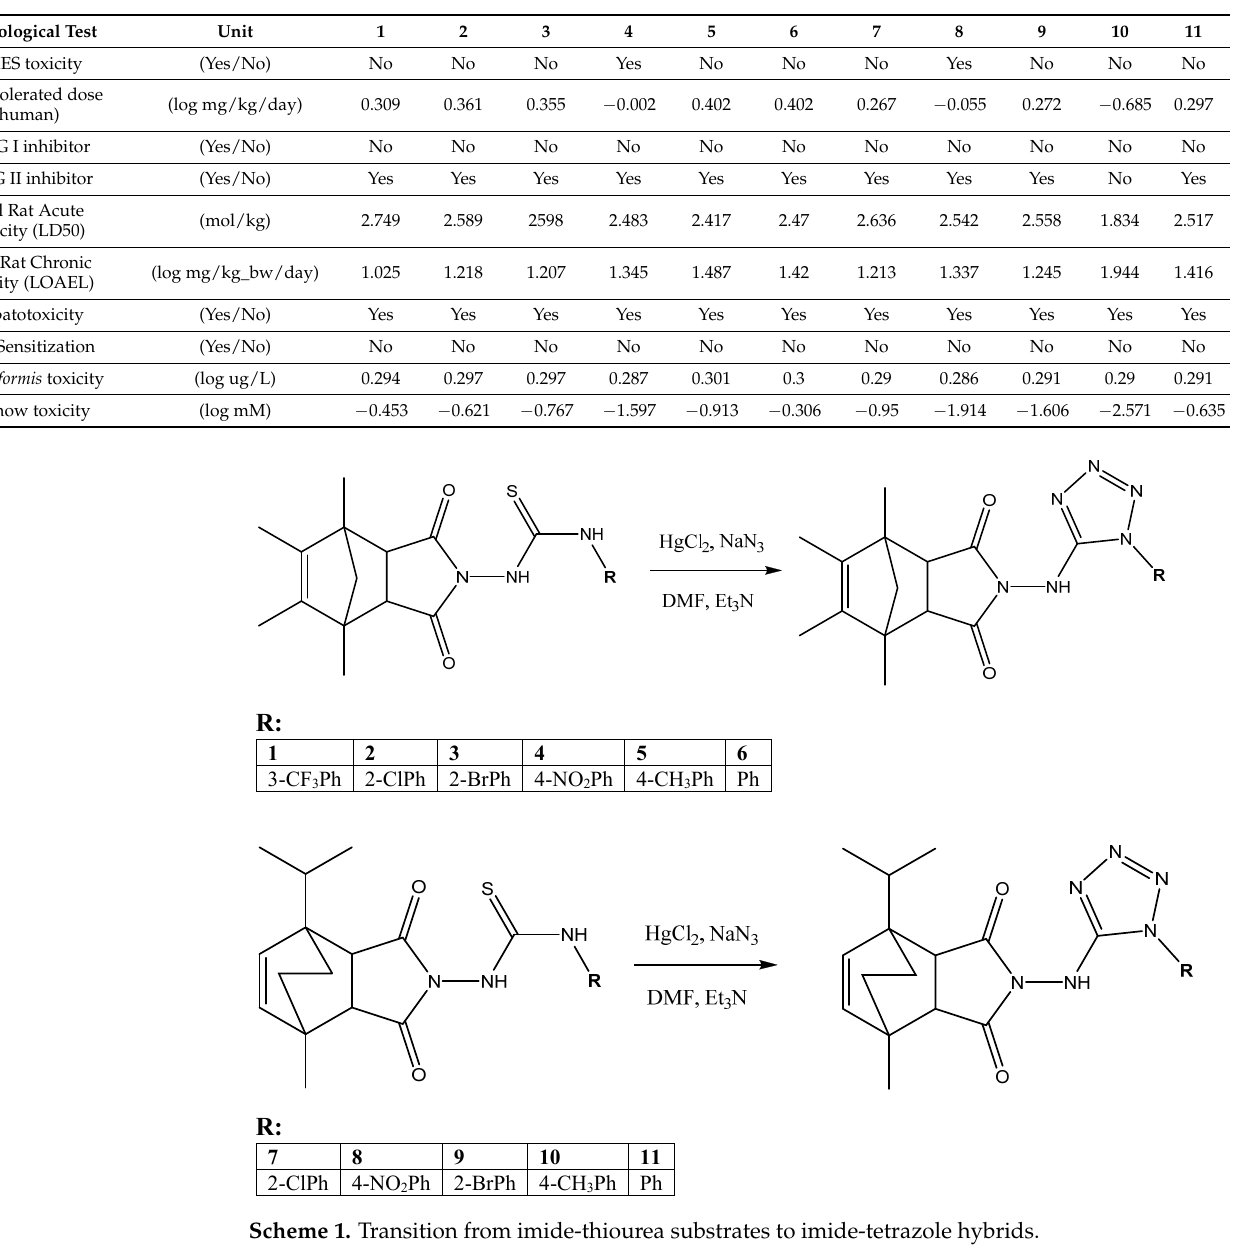
Table 2. The toxicological parameters of synthesized imide-tetrazole derivatives estimated using pkCSM